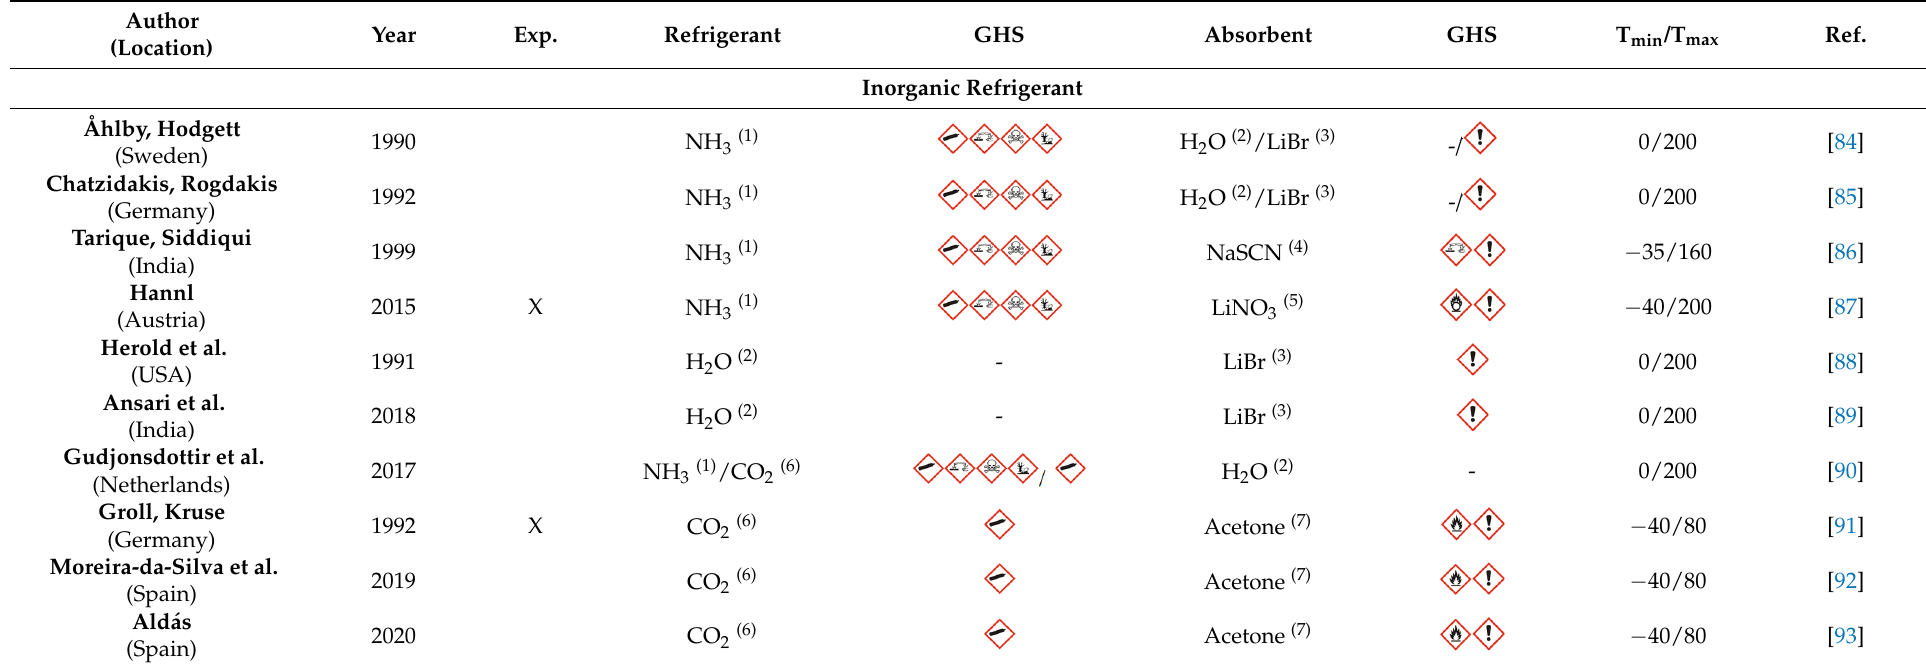
Table 2. Overview of alternative working fluid pairs proposed in the literature for use in ACHP cycles.